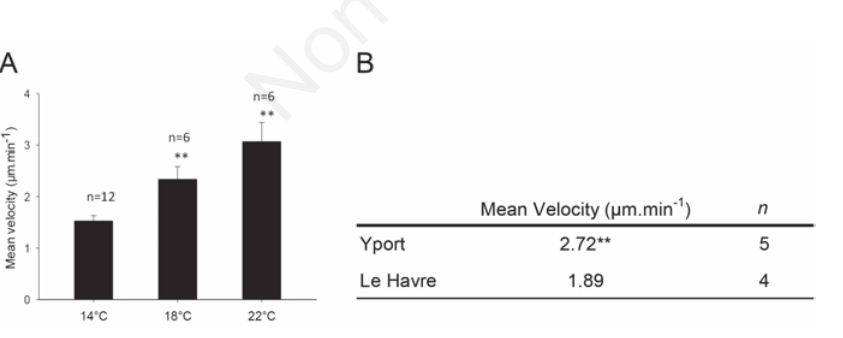
Figure 2. Effects of bath temperature or mussel sampling site on hemocyte velocity. A) Dependence of mean hemocyte velocity to temperature. Freshly collected hemocytes were deposited in a temperature-controlled recording chamber filled with marine physiologi- cal saline solution. Replicated cell cultures obtained from individuals n=6-12 collected from a mussel bed of basin Vetillard (seaport of Le Havre). Mean cell velocities were determined from 20 trajectories recorded during 30 min. B) Dependence of mean hemo- cyte velocity to mussel origins. Hemocytes were collected from mussels originating from the rocky shore of Yport or from the seaport of Le Havre, placed at 14°C and used to 30- min endpoint mean migration velocity recordings. Migration speeds are expressed as mean±SEM. Values significantly different from velocity of hemocytes from Le Havre at 14°C are indicated (*P<0.05, **P<0.01, ***P<0.001, Student’s t